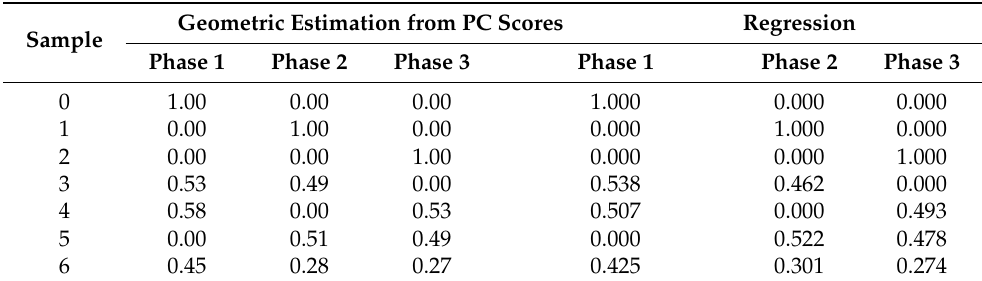
Figure 7. Original data ( a ), PC scores ( b ), PC loading ( c ) and calculation of Euclidean distances from PC scores ( d ) from X-ray powder diffraction data by ternary mixtures. Data points A, B, and C correspond to powder diffraction profiles from monophasic mixtures, data points AB, AC and BC to binary mixtures and ABC to a mixture containing an equal amount of the three crystal phases. Table 1. Results of the quantification of the phases in polycrystalline mixtures represented in Figure 6 by PCA scores and multilinear